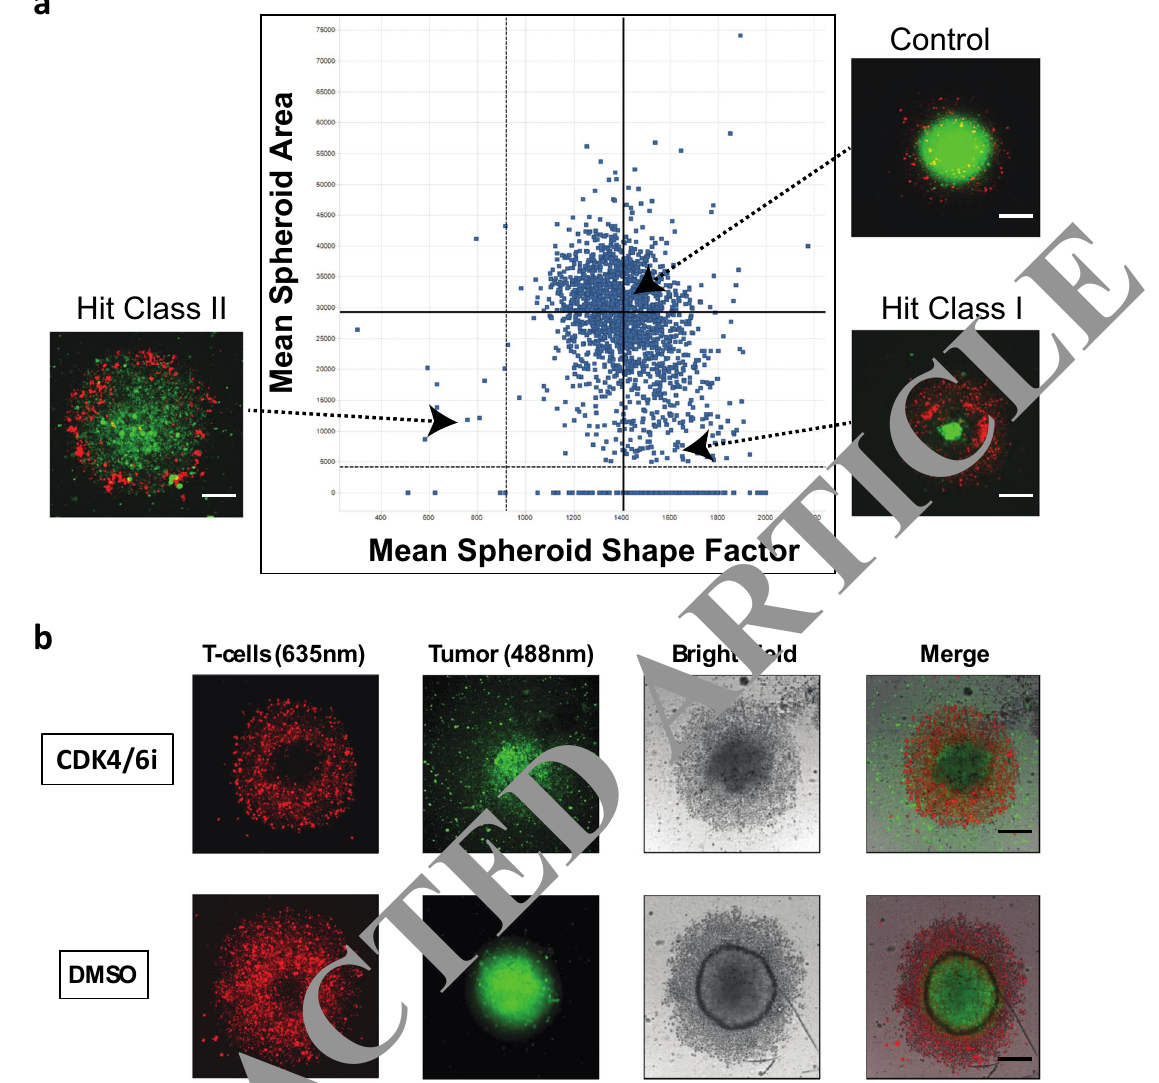
Fig. 3 Characterization of hit compounds from T-cell/spheroid HTS. a Scatter plot showing the results of the 1770 compound high-throughput phenotypic screen for enhancers of anti-tumor T-cell function. The majority of compounds did not elicit any change in tumor spheroid phenotype and clustered with the DMSO vehicle control samples. Hit compounds that yielded desirable anti-tumor phenotypes were broadly classi fi ed by their ability to reduce tumor size (Hit Class I) or size and structure (Hit Class II). Solid lines indicate the mean for either the spheroid area ( y axis) or the spheroid shape factor ( x axis); dotted lines indicate three standard deviations from the mean. b Example of a hit compound from the screen. Tumor spheroids treated with the CDK4/6 inhibitor are shown in three different channels alongside the DMSO negative control. Scale bars indicate 100 µ